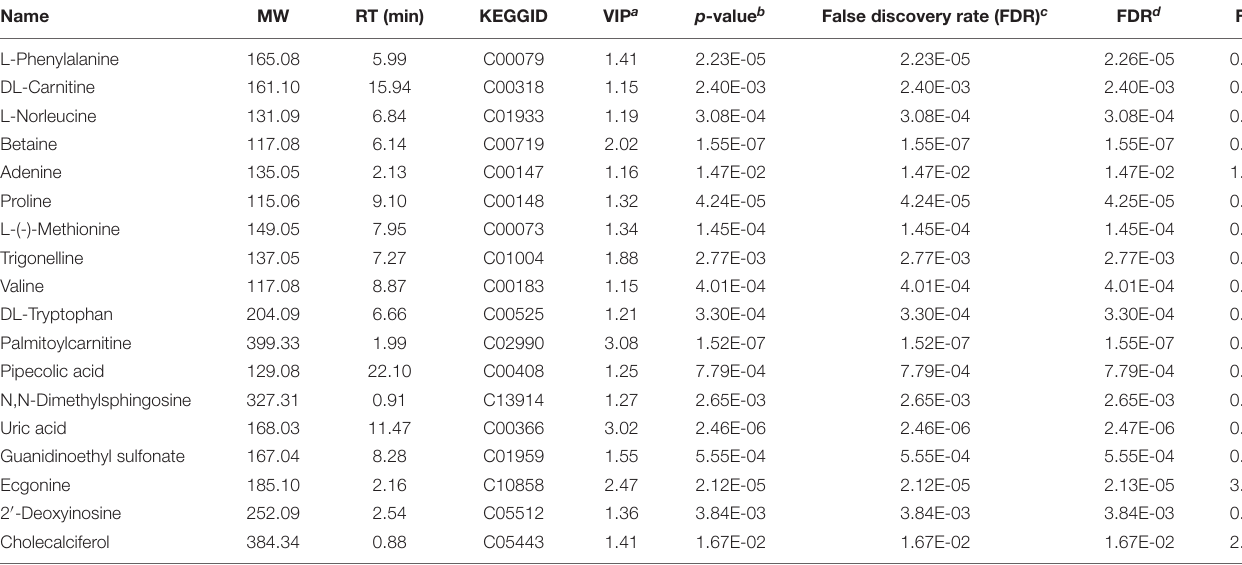
FIGURE 5 | Orthogonal partial least-squares discriminant analysis (OPLS-DA) mode and S-plot of the subacute traumatic brain injury (TBI) vs. sham group. (A) OPLS-DA models for cortical TBI vs. sham. (B) OPLS-DA models for TBI of the hippocampus vs. sham. (C) OPLS-DA model for TBI of the cortex shown in the S-plot. (D) OPLS-DA model for TBI of the hippocampus is shown in the S-plot, which illustrates the relationship between correlation and covariance. TABLE 1 | List of significant metabolites identified from the orthogonal partial least-squares discriminant analysis (OPLS-DA) mode for cortical traumatic brain injury